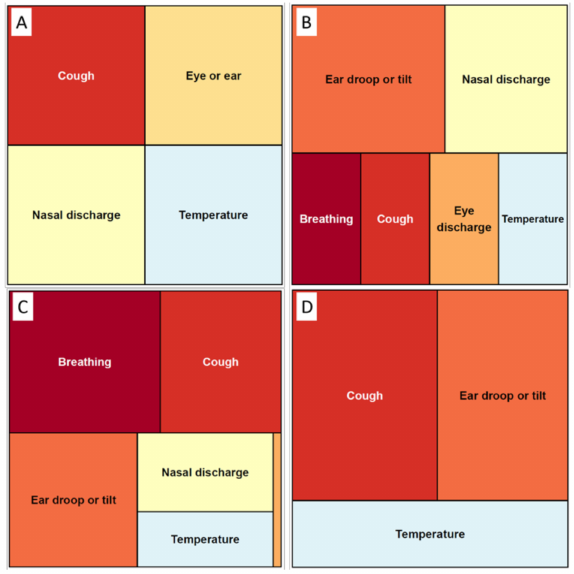
Figure 1. Treemap of the relative weights of different clinical signs included in various scoring systems used to detect bovine respiratory disease complex in calves. The size of the square is proportional to the specific clinical sign weight in the Wisconsin calf respiratory score ( A ) [7], California score ( B ) [8], Qu é bec modified California score ( C ) [9], and Qu é bec veal calf respiratory score ( D ) [10]. The map clearly shows the variable signs included and the relative impact on the total score of the same clinical